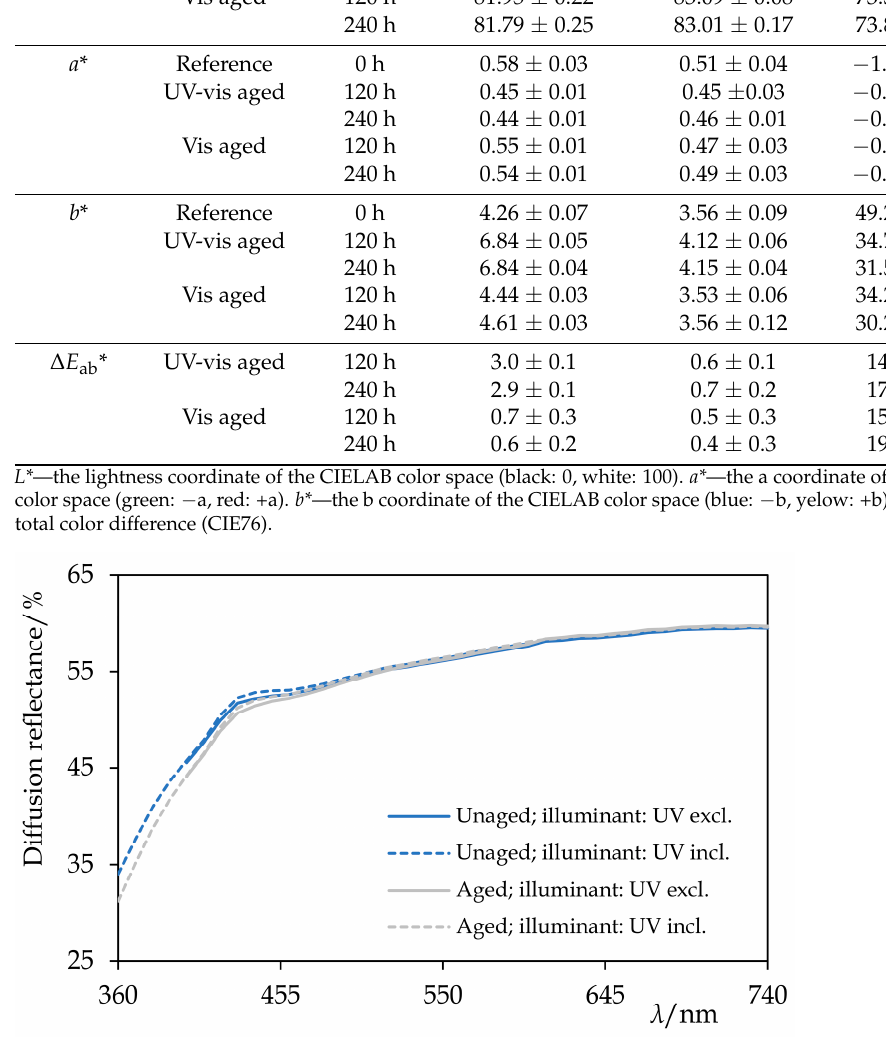
Figure 13. The diffuse reflectance spectra of hydrogenated Permulgin 3274 before and after the artificial ageing by the exposure to UV-vis radiation for 240 h. Information about the illuminant used during the acquisition of the spectra is given. Note the absence of the fluorescence and the excellent stability of the